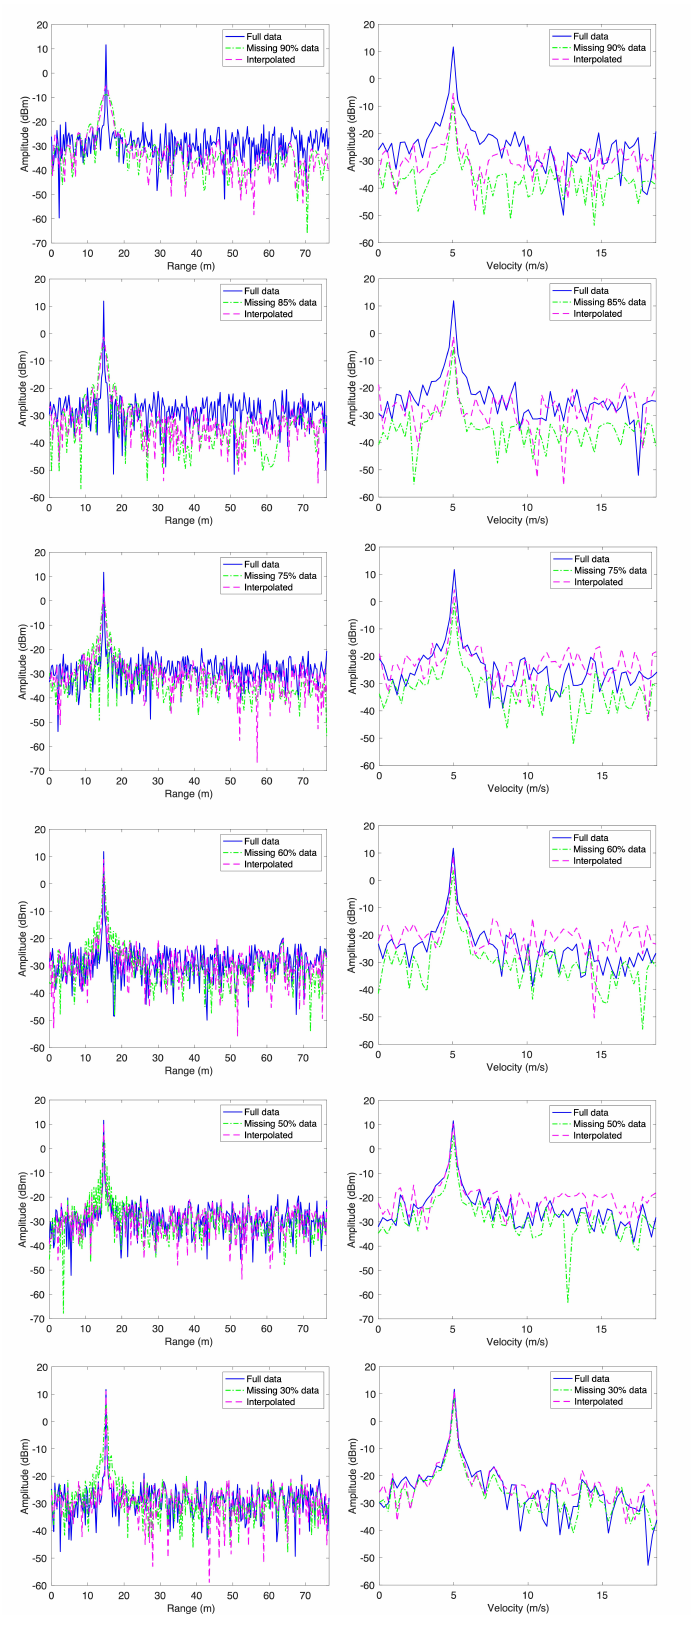
Figure 13. Comparison of range and Doppler profiles in terms of different percentages of interfer- ing